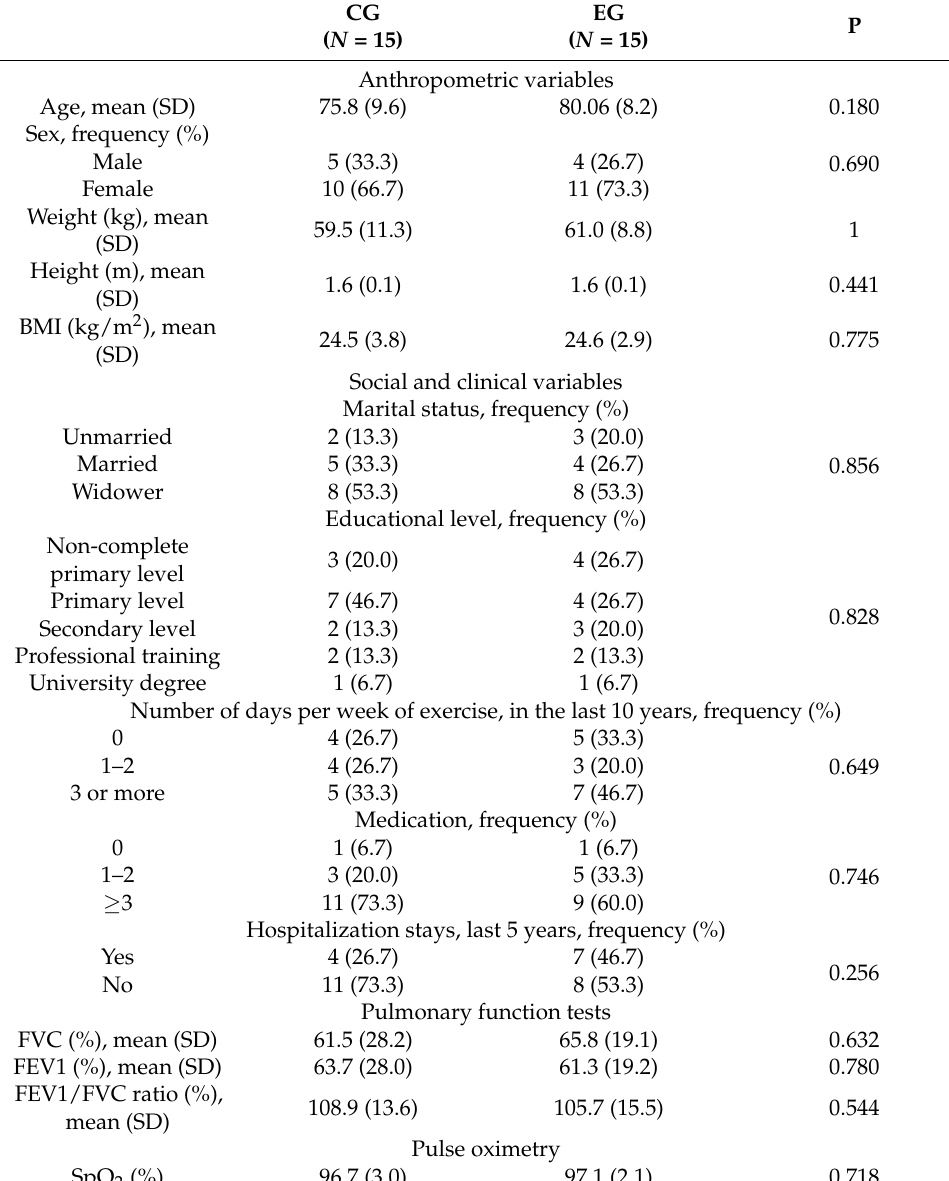
Table 2. Baseline comparisons of demographic and clinical